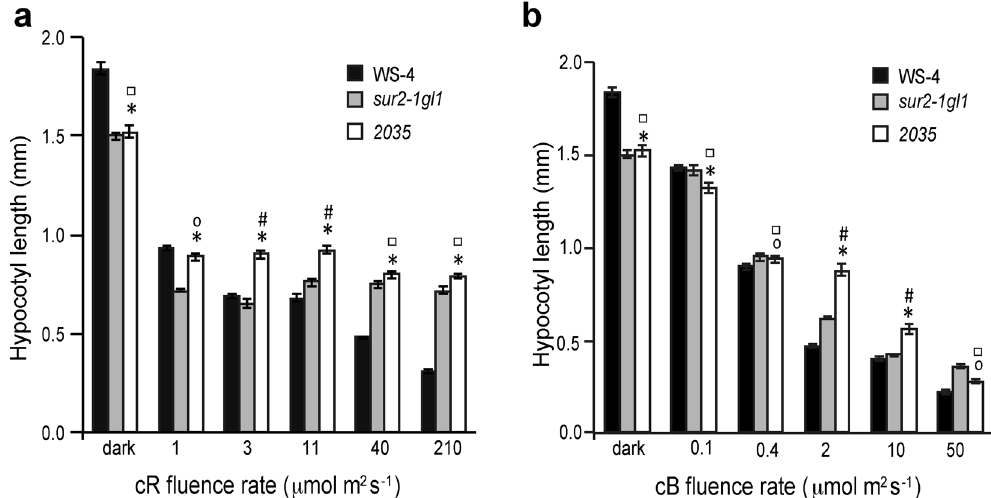
Figure 4. The csn4-2035 mutation affects red and blue light perception in a sur2-1gl1 background. All measurements were performed on three independent biological replicates with a minimum of 40 seedlings each, as described in the Methods. Error bars indicate standard error. One-way ANOVA combined with Tukey’s multiple-comparison post-test revealed that the values indicated by ( * ) were significantly different from Ws-4 values; (#) indicates values significantly different from sur2-1gl1 values; while (o) and ( ◻ ) indicate values not significantly different from Ws-4 and sur2-1gl1 values, respectively; (P < 0.05; n >